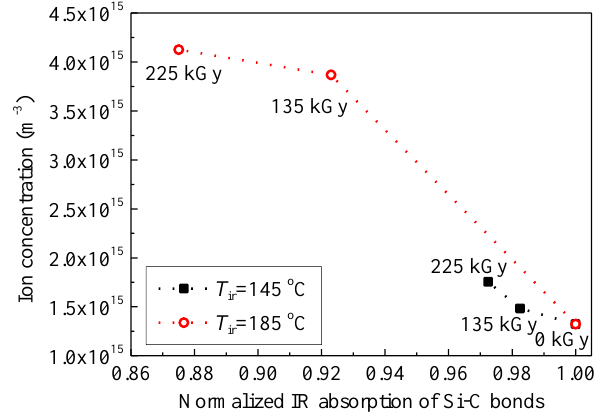
ir of 145 and 185 °C.